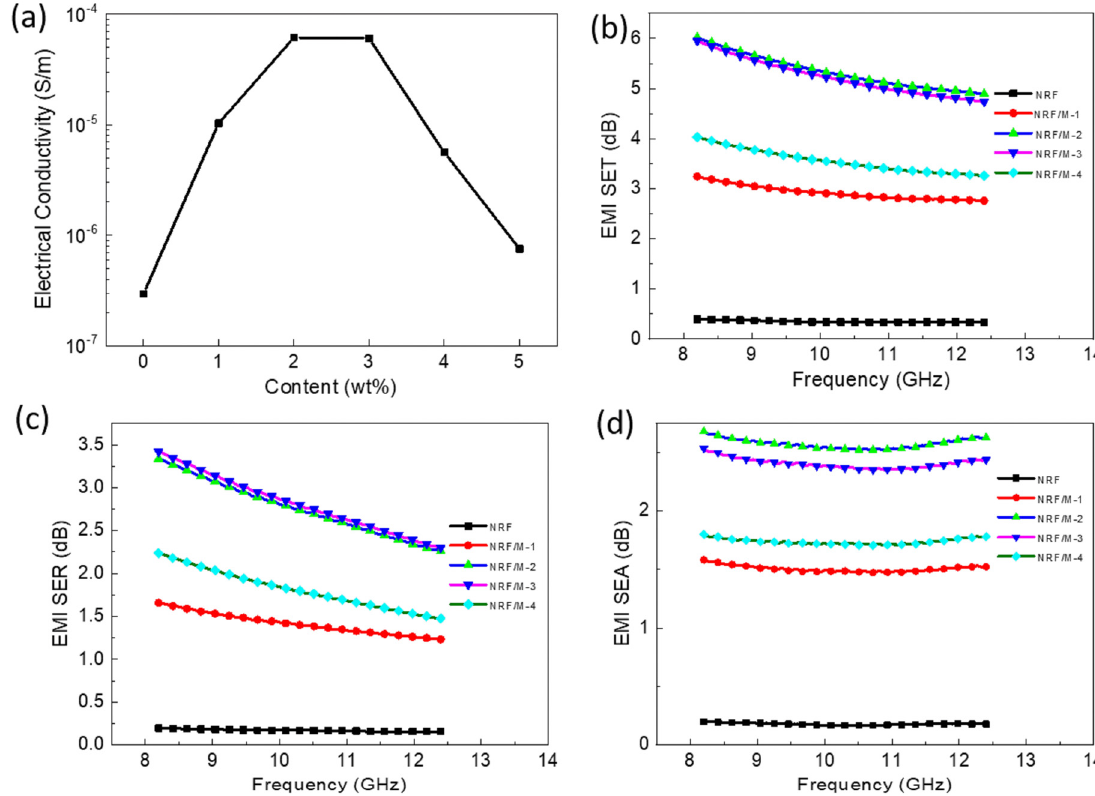
Figure 6: ( a ) Electrical conductivities, ( b ) total EMI shielding e ff ectiveness ( SET ) , ( c ) microwave re fl ection ( SER ) , and ( d ) microwave absorption ( SEA ) of NRMF nanocomposites at di ff erent MXene